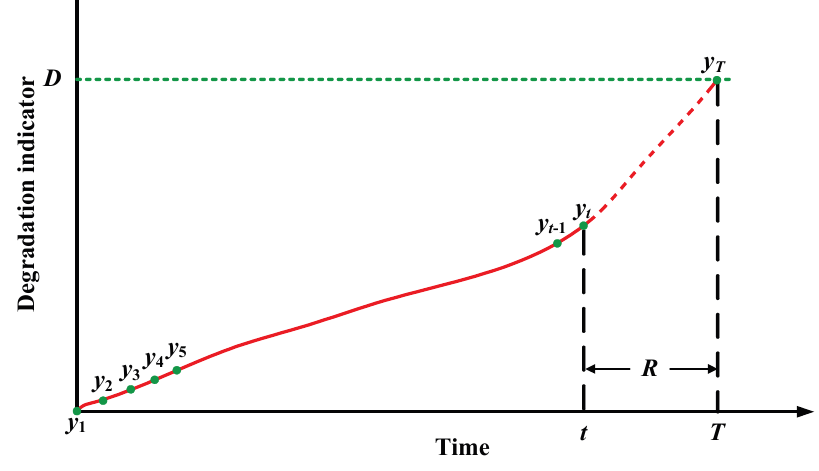
Figure 1. Illustration of degradation process and RUL